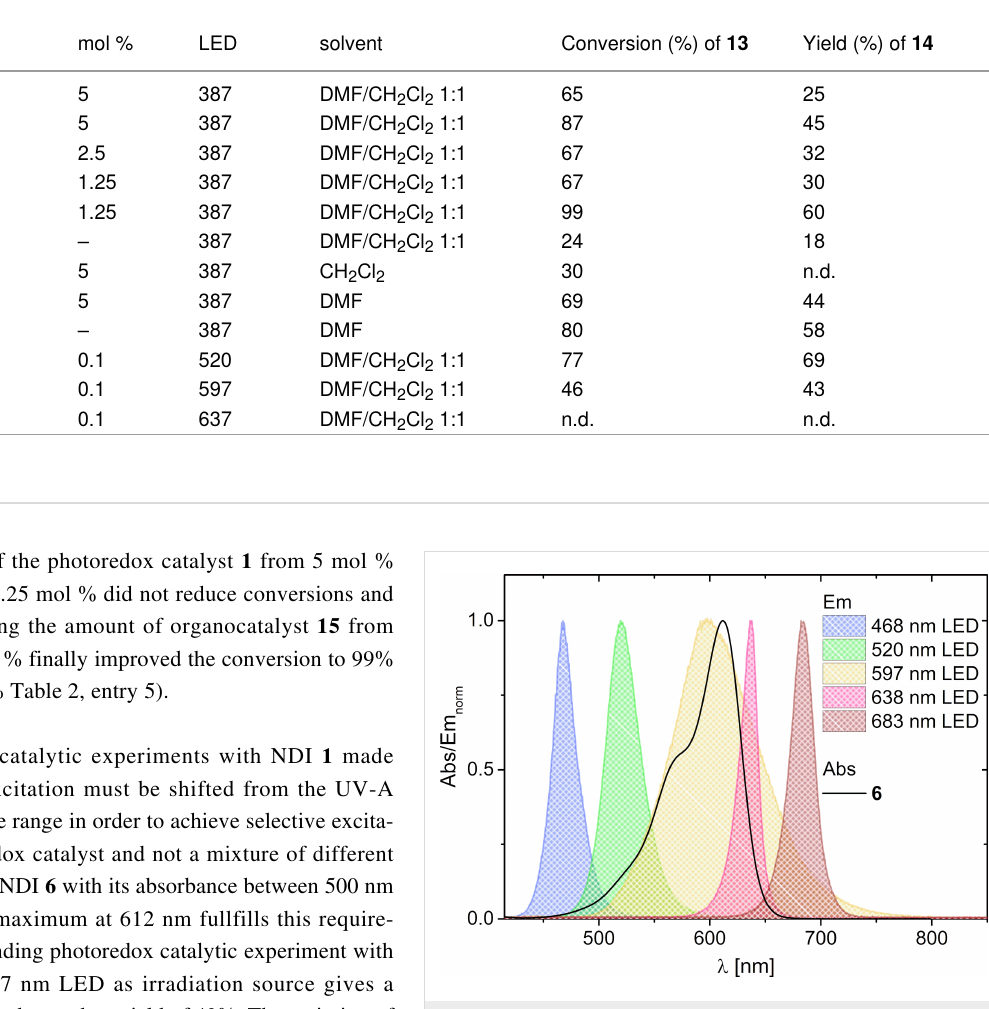
Figure 2: Normalized absorbance of cNDI 6 in comparison to normal- ized emission of the 468 nm, 520 nm, 597 nm, 638 nm and 683 nm